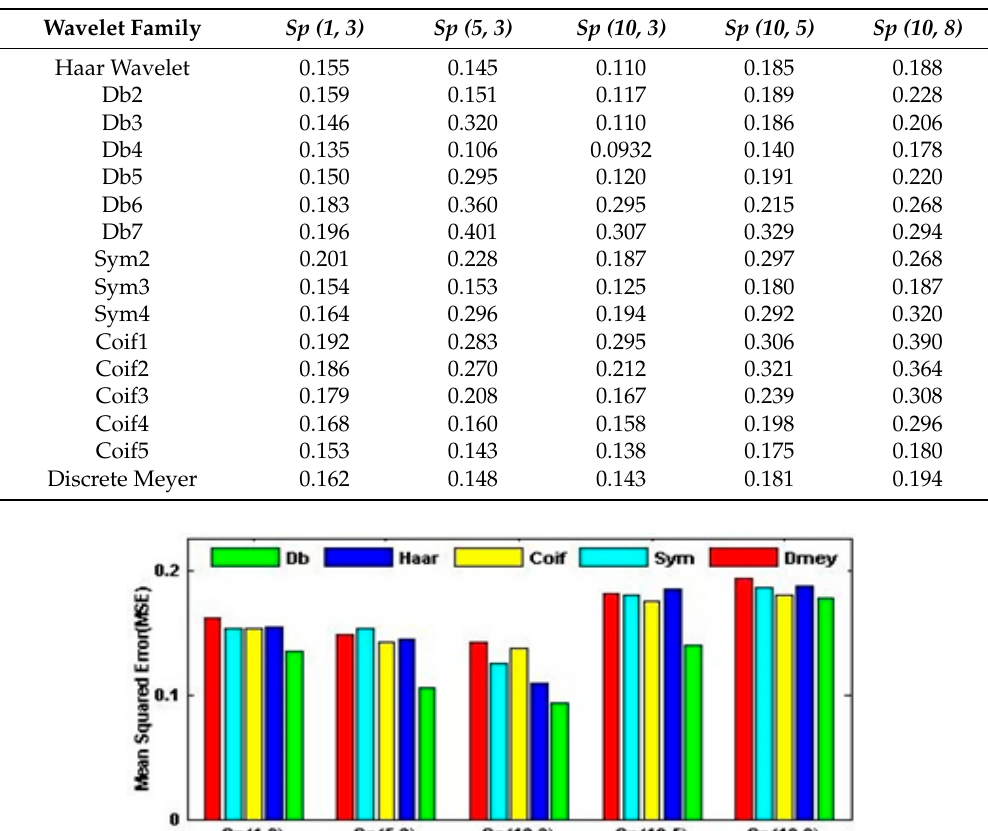
Table 1. Root mean squared error (RMSE) values of the hybrid WNN.